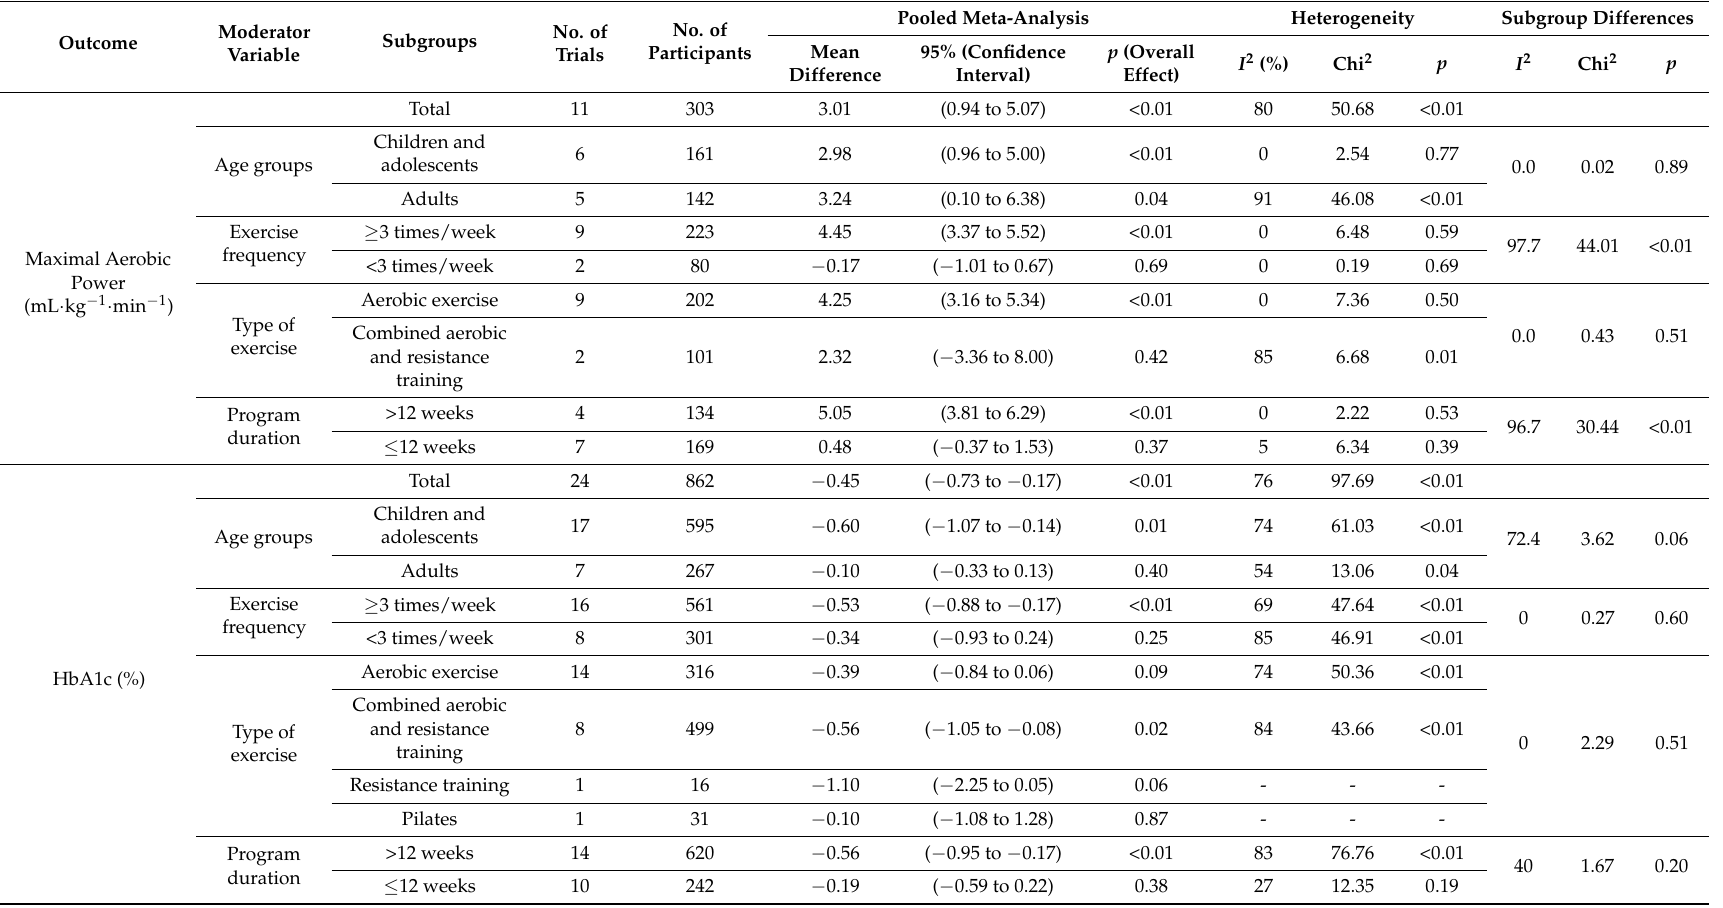
Table 2. Subgroup analyses of moderator variables of maximal aerobic power, HbA1c, daily insulin dosage, and total